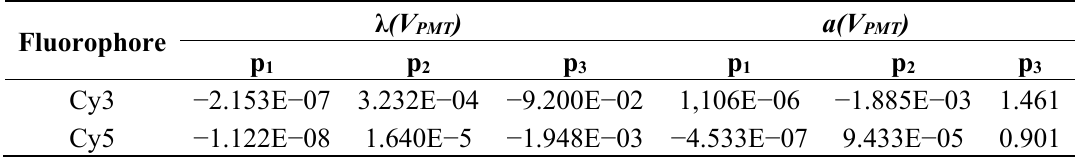
Table 3. Parameters of the final